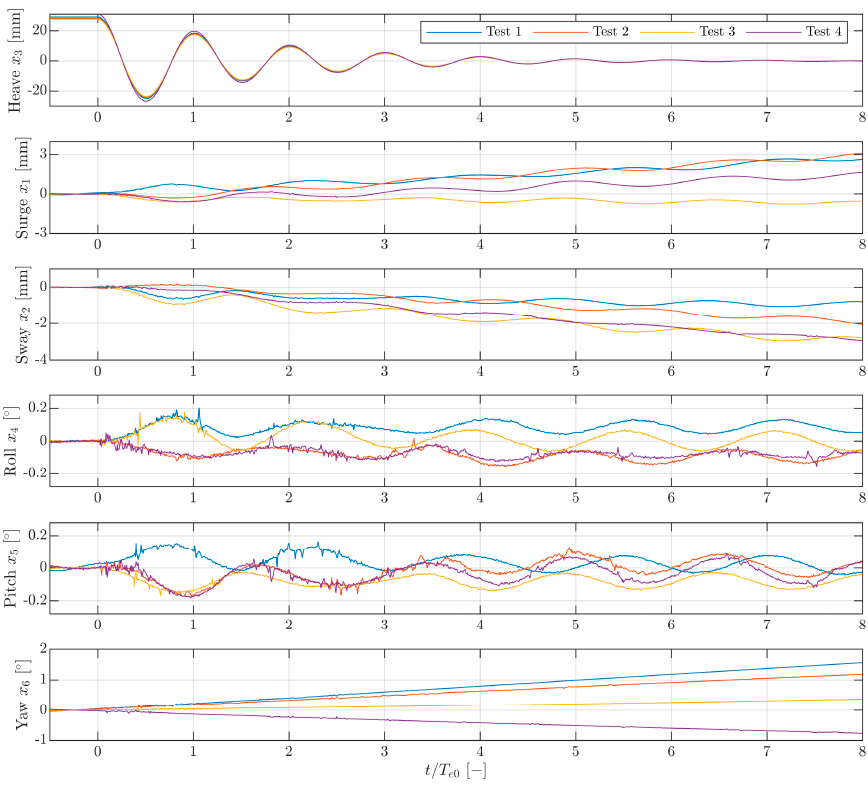
Figure A10. Time series of the measured motions in six DoF for H 0 = 0.1 D .